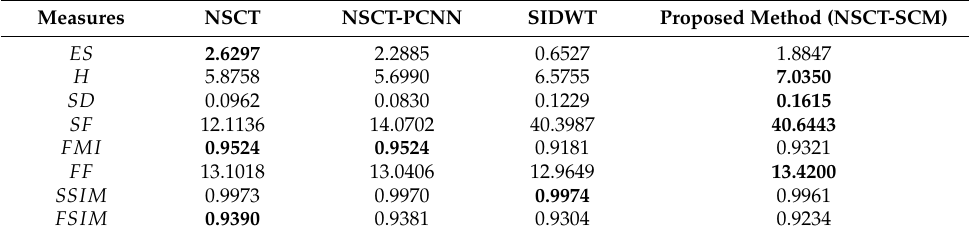
Table 1. The evaluation results of the ROI in Figure 5a–d.